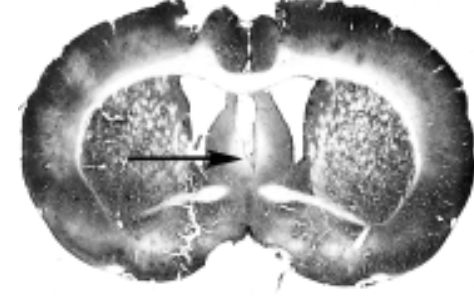
Figure 2. Photomicrograph of a hematoxylin-stained transverse section showing the site of in- jection into the paraventricular nucleus (arrow). Magnification